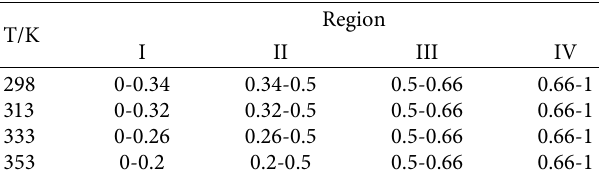
Figure 6: First-order difference curve of equilibrium speciation as a function of CO Table 5: Four regions of CO 2 absorption in MEA with CO 2 loading from 0 to 1 at different